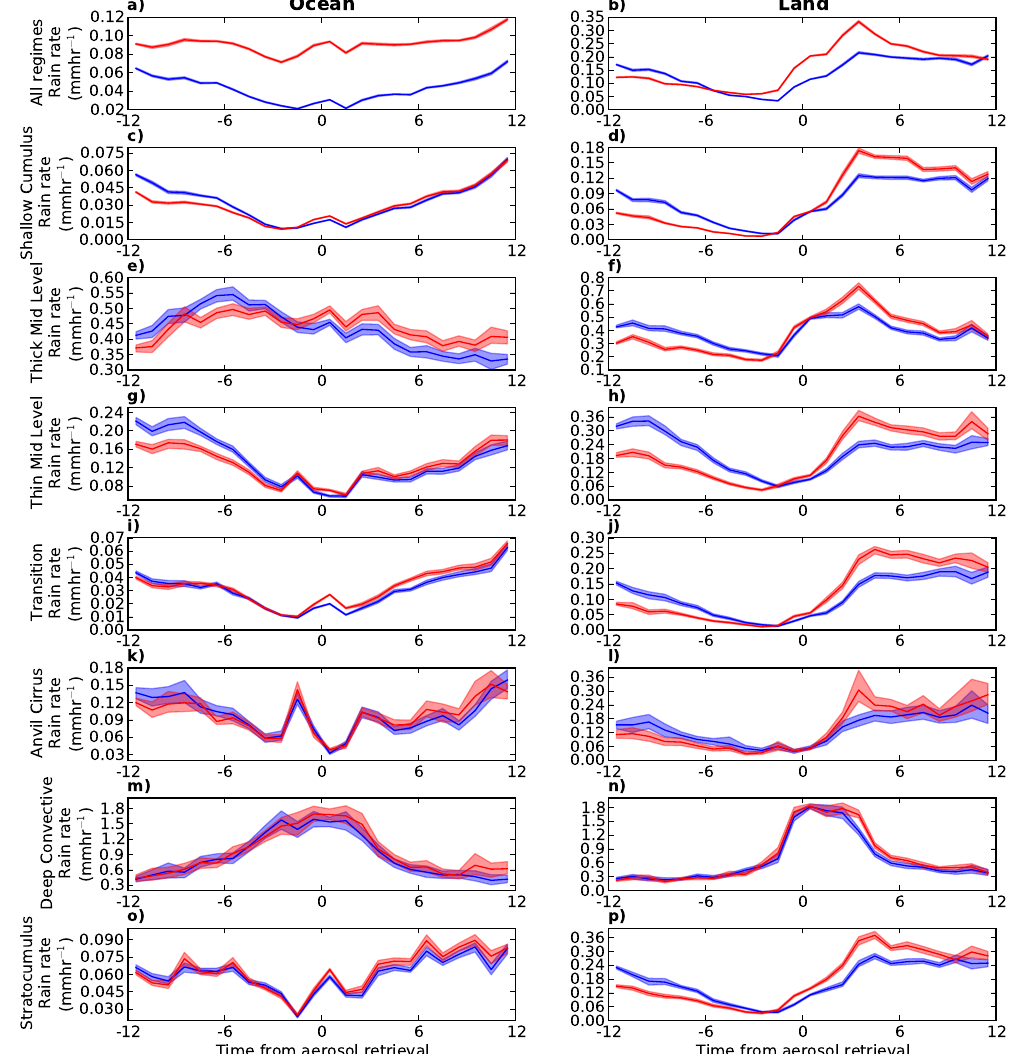
Figure 2. Mean precipitation rain rates at times before and after the Aqua MODIS aerosol and cloud retrieval at T + 0 (13:30LST) for the region 30 ◦ N–30 ◦ S. The development in a high-AI environment is shown in red and a low AI environment in blue. Statistical errors are shown at 95% significance. The top row (“All regimes”) shows the development of precipitation if cloud regimes and the AI–CF relationship are not accounted for. These plots are created from MODIS L3 cloud and aerosol data and TRMM 3B42 3h merged precipitation data over the five years 2003–2007. Numerical values for the mean precipitation within T + 0 → + 6 are given in Table